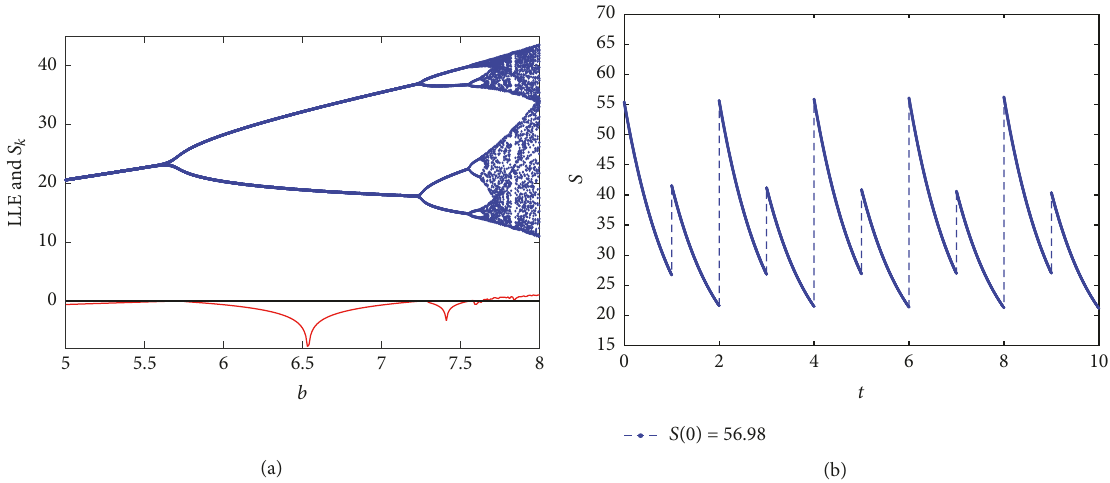
Figure 3: (a) The bifurcation diagram and largest Lyapunov exponent of system (39) for 𝑏 ∈ (5, 8) ; (b) the period- 2𝑇 solution of (39) with 𝑏 = 5.9 and the initial point (0,56.98)